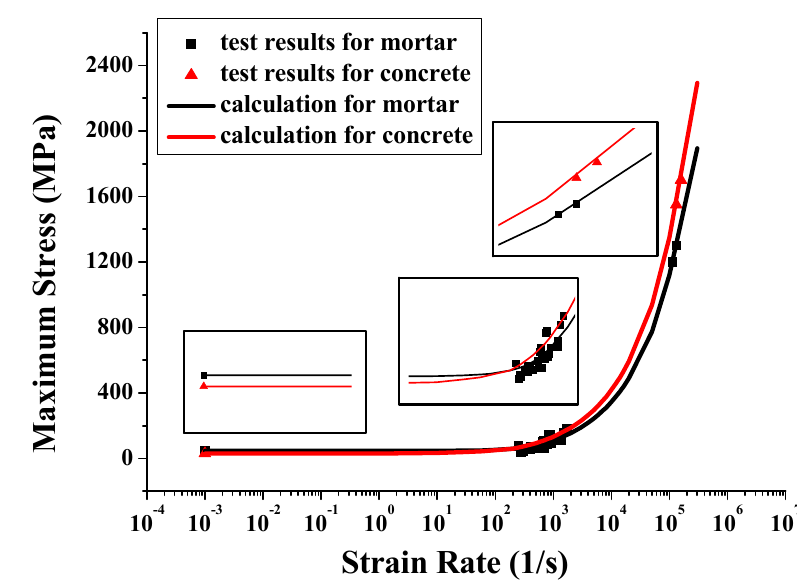
Figure 4: Dependence of limit compression stress on strain rate. Black squares are the experimental values for concrete [4]; black line is predictions of Eq. (2) for concrete; red triangles are the experimental values for mortar [4]; and red line is predictions of Eq. (2) for